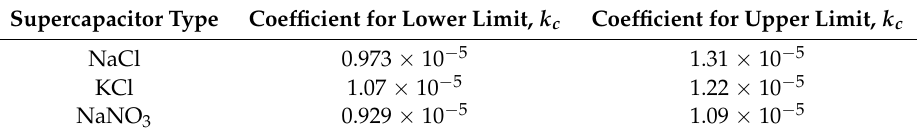
Table 1. Leakage current model parameters based on results given in